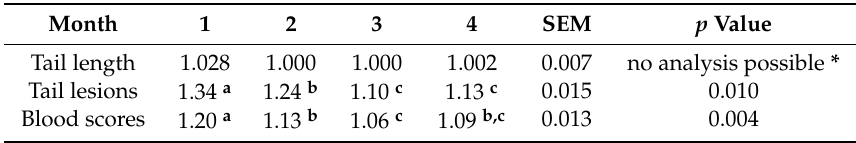
Table 3 Mean tail length, lesions, and blood scores over time with SEM and p value; different superscripts within a row indicate a statistical difference ( p < 0.05).